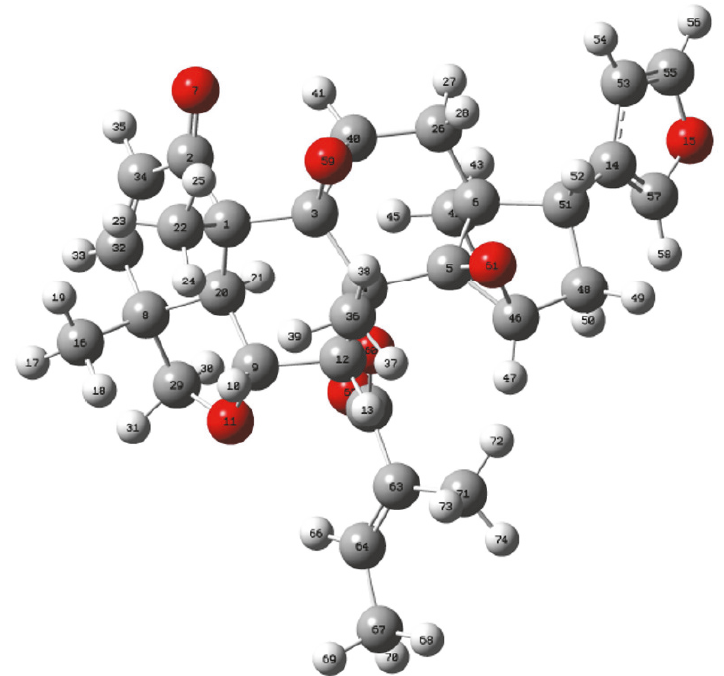
Figure 1: Ground state geometry of Rubescin E at B3LYP/6-311++G(d,p) in chloroform